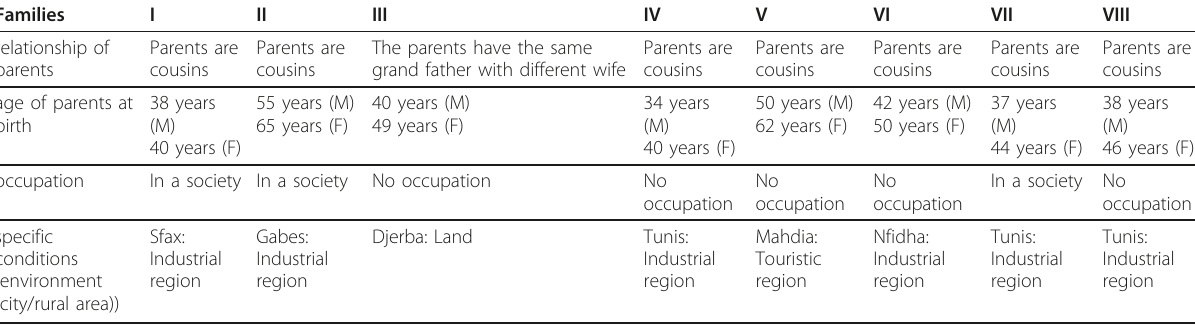
Table 4 Background of the MPS I